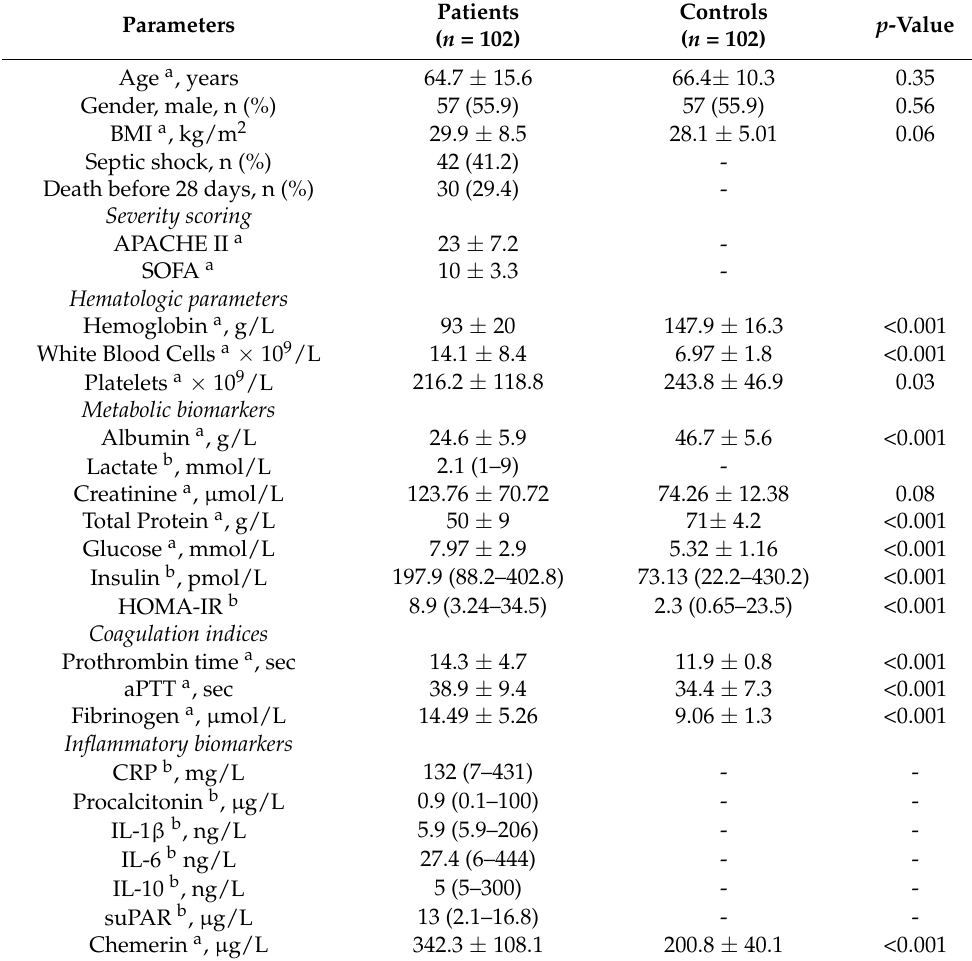
Table 1. Clinical and laboratory baseline variables * of patients and controls ( n =